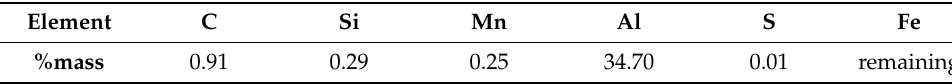
Table 1. Chemical composition of high-aluminum cast iron. Element C Si Mn Al S Fe %mass 0.91 0.29